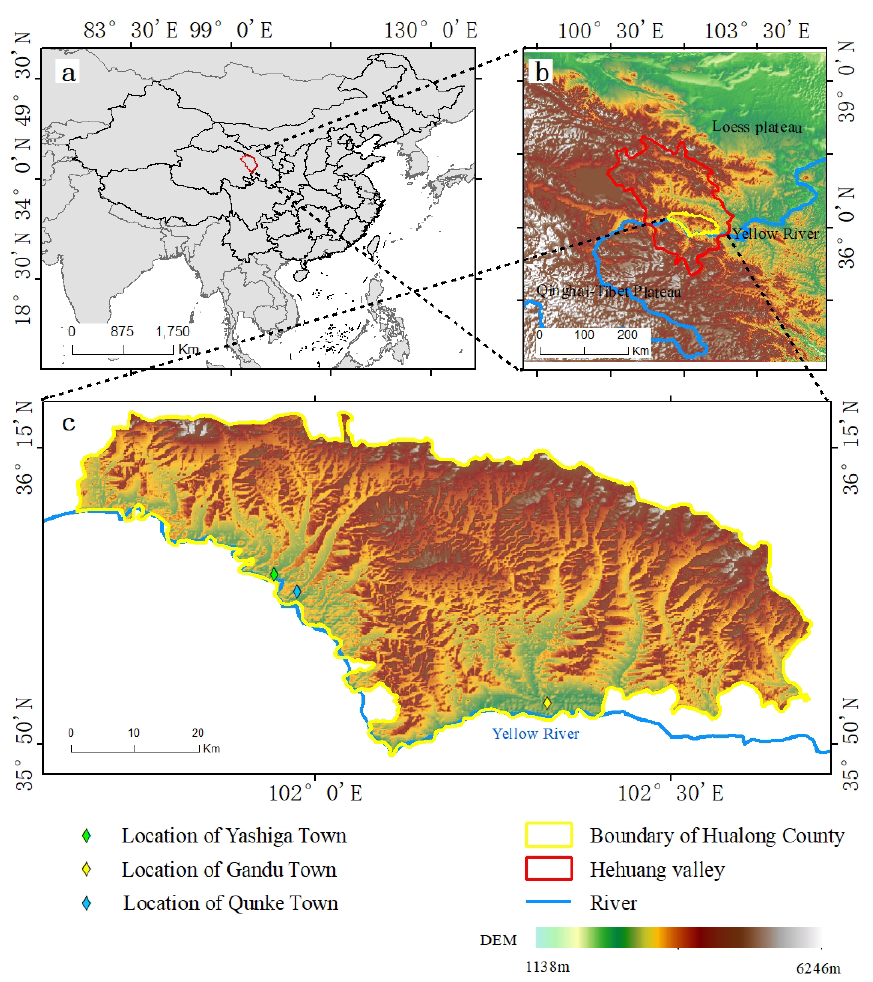
Figure 1. Study area. ( a ) Location of the Hehuang Valley; ( b ) Location of Hualong; ( c ) Hualong digital elevation model.